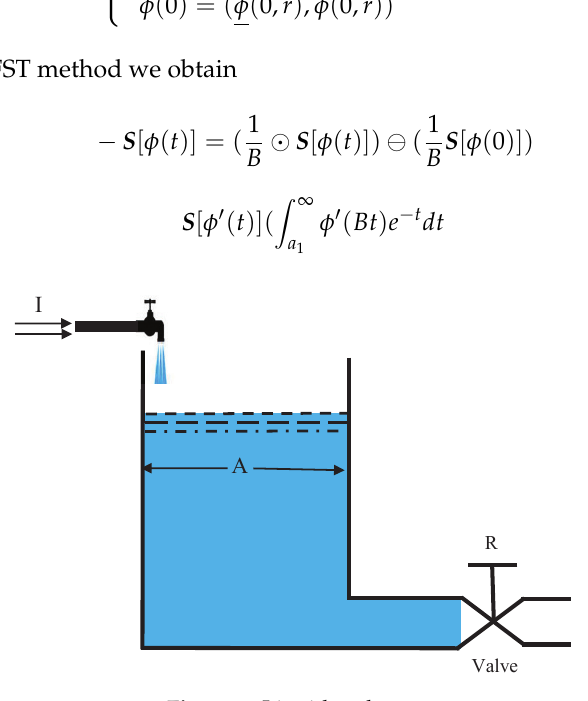
Figure 5. Liquid tank